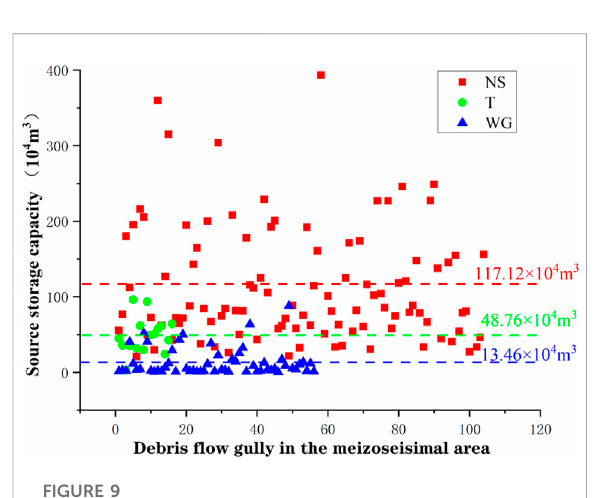
FIGURE 9 The source reserves of the three types of debris fl ow